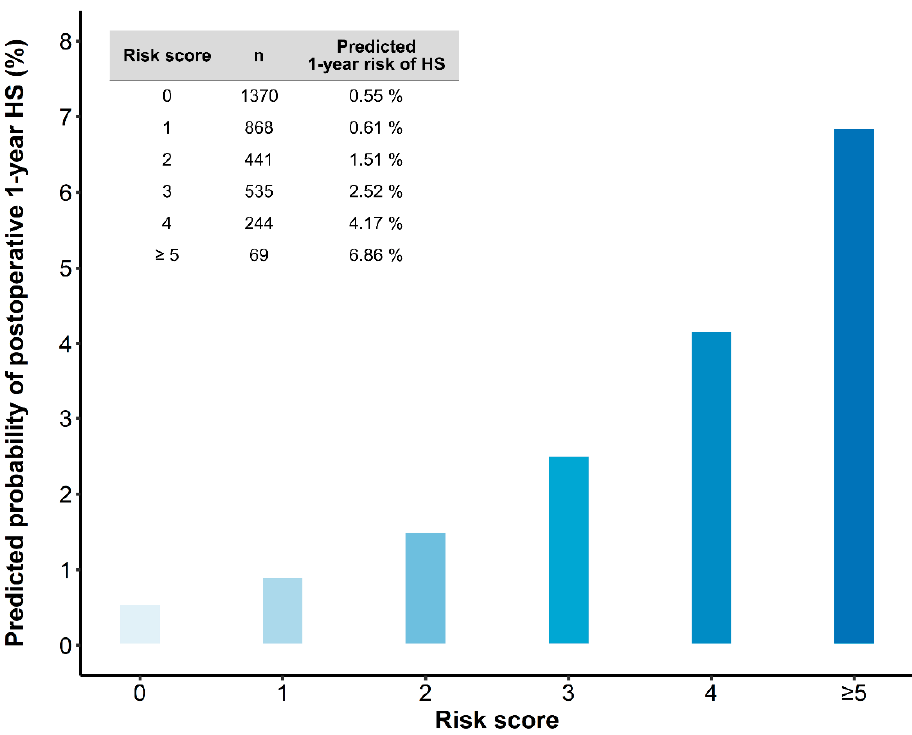
Figure 2. The predicted 1-year risk of hemorrhagic stroke according to the developed risk score. Risk score can be calculated according to the variables in Tables 3.